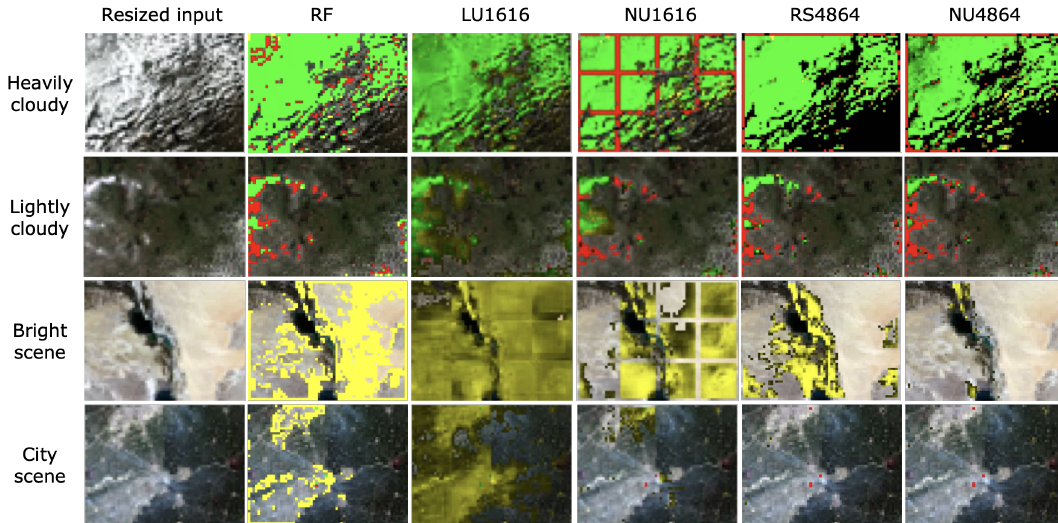
Figure 13. Selected segmentation results for heavily cloudy, lightly cloudy, bright, and city scenes (RF: Random Forest, LU1616: Zhang’s method, NU1616: Proposed method with patch decomposition, RS4864: Jeppesen’s method, NU4864: Proposed method without patch decomposition). Green, red, and yellow represent true positive, false negative, and true negative,